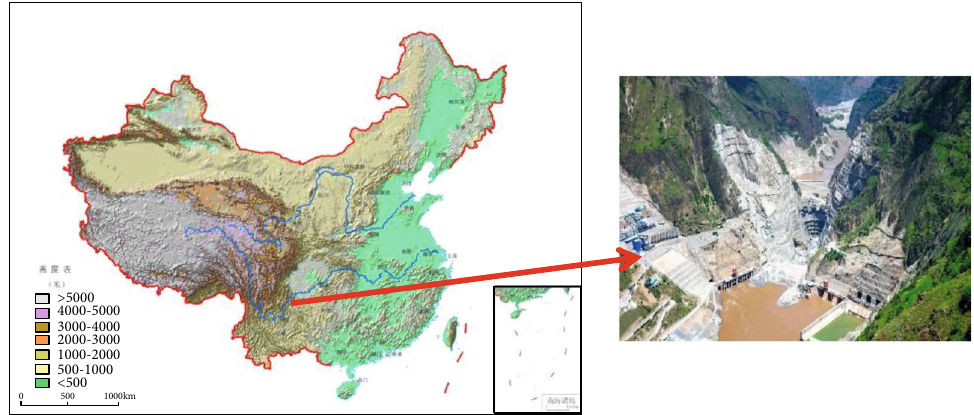
Figure 1: Geographical location of Wudongde Hydropower